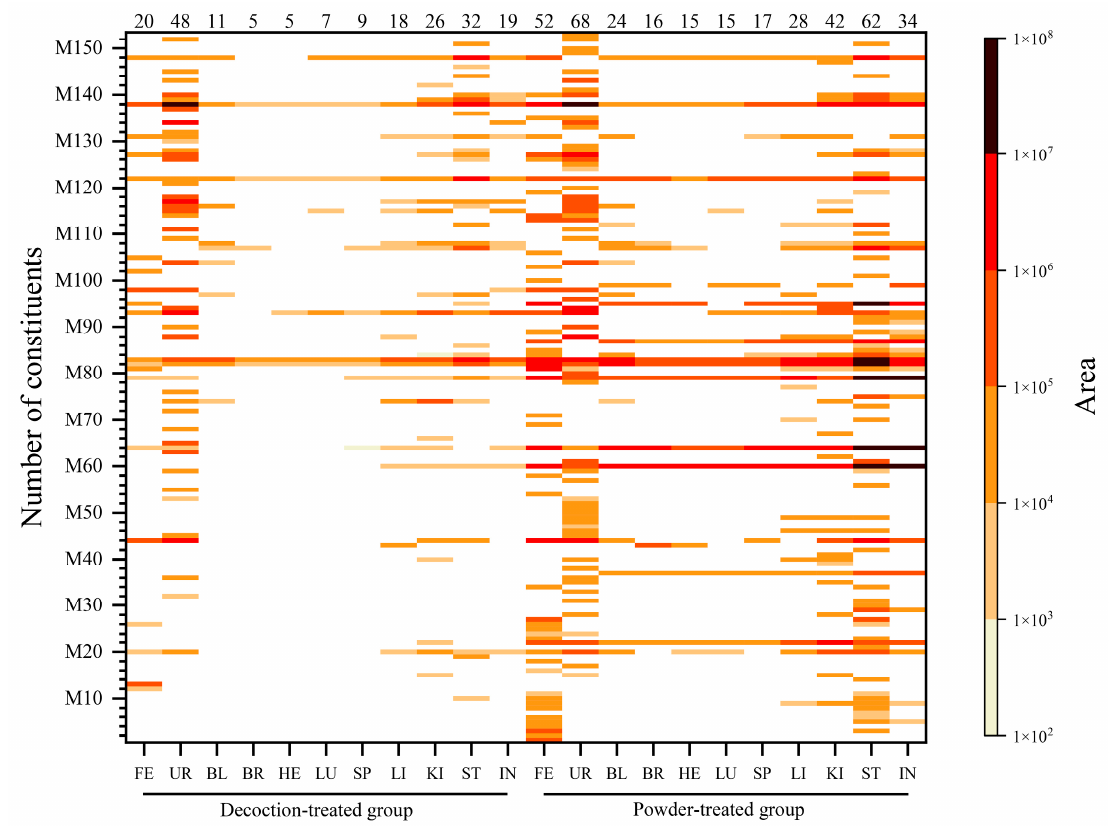
Figure 3. Heatmap of identified compounds. Peak area of compounds identified in feces, urine, blood, and eight organ samples (brain, heart, lung, spleen, liver, kidney, stomach, and small intestine) are illustrated using heatmaps, in which the color shade (shown in the right of the ordinate) indicates the peak area size of a compound. Darker band indicates a larger peak area. Serial numbers of compounds (shown on the ordinate) were sorted by the retention time of all compounds identified in each sample, and the larger the compound number, the higher the polarity. Numbers of compounds identified in each sample are shown above the horizontal axis. FE: feces; UR: urine; BL: blood; BR: brain; HE: heart; LU: lung; SP: spleen; LI: liver; KI: kidney; ST: stomach; IN: small intestine.